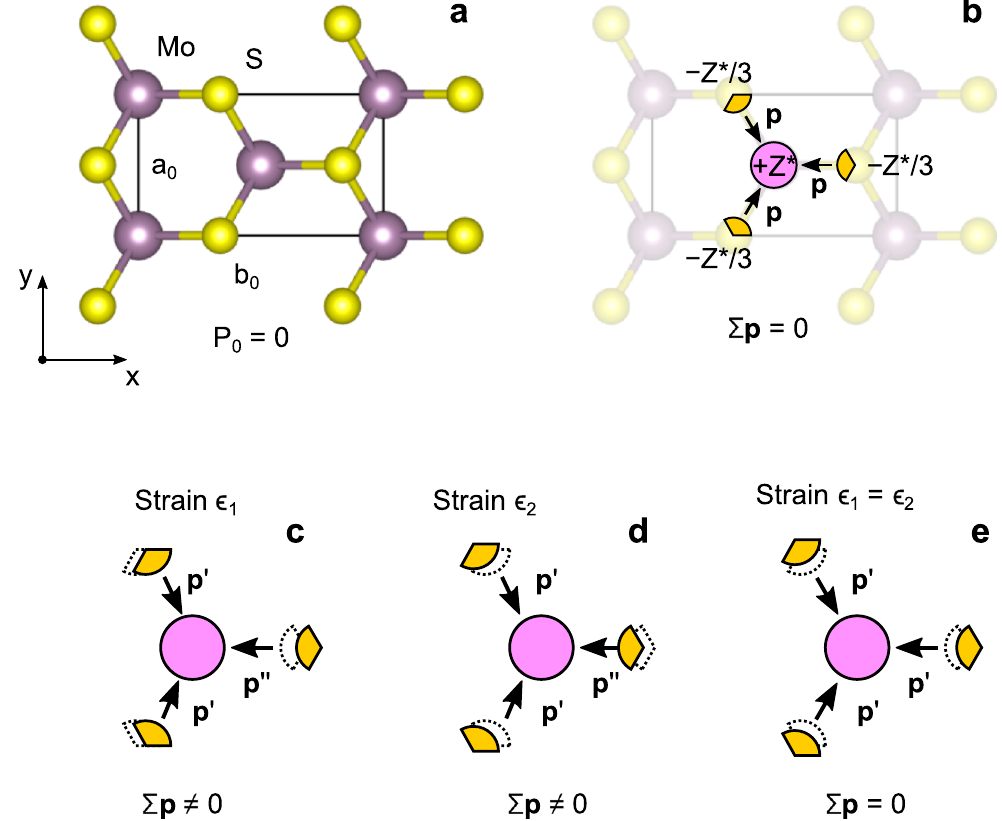
Figure 2. Strain-induced change in electronic polarisation of hexagonal MoS 2 . ( a ) Rectangular unit cell. ( b ) Cancellation of local dipoles p induced by of the charge transfer ± Z * due to the C 3 rotational symmetry, which results in the vanishing of a spontaneous polarisation P 0 . ( c , d ) Symmetry breaking due to uniaxial strain induces a macroscopic dipole moment giving rise to the strain-induced polarisation. ( e ) Under the equal plain strain condition ( ϵ 1 = ϵ 2 ), the symmetry is preserved. Thus no change in polarisation should be